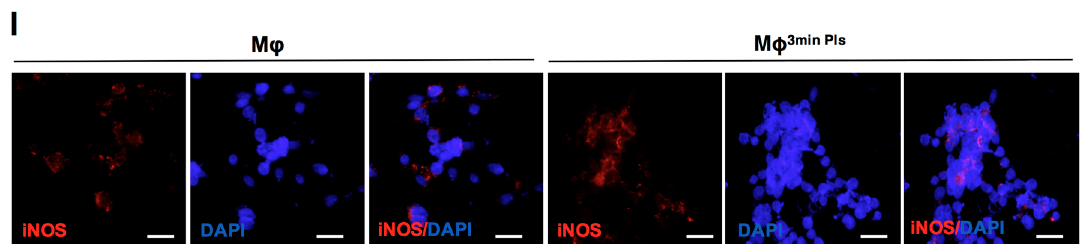
Figure 4. Expression of cold plasma-stimulated macrophage surface markers and release of cytokines by macrophages exposed to the plasma through M1 and M2 polarization. ( A ) Schematic diagram for the detection of released secretion factors during tumor-macrophage cell co-culture. To this end, plasma-stimulated THP-1 macrophages (1 × 10 5 cells/mL) were seeded in the lower chamber of the same transwell as mentioned above, while cancer cells were seeded on the top of the insert. ( B ) Microarray analysis was performed on plasma-stimulated macrophages and expression data were generated by Affymetrix Expression Console software version 1.1. To classify the co-expression gene group with a similar expression pattern, we performed hierarchical clustering using MEV (MultiExperiment Viewer) software 4.4 (www.tm4.org). More than 2-fold up genes are shown in Figure 4B ( C ) Go analysis of various signaling molecular pathways involved in altered gene expression of plasma-stimulated macrophages. ( D ) qPCR was used to validate the gene changes (related to M1 and M2 polarization) in plasma-stimulated macrophages. ( E , F ) The release of cytokines (TNF- α and IL-12) was evaluated in cell culture media after 24 h of co-culture using an ELISA assay in THP-1 treated cells as per the indicated panels. ( G ) Arginase-1 (ARG-1) was analyzed in cell culture media after 24 hrs. of co-culture using an ELISA assay in THP-1 treated cells as per the indicated panels. ( H ) Cellular metabolic viability was determined in U251 MG cells when co-cultured with plasma-stimulated macrophages in the presence of lenalidomide (2 µ M, LD), a TNF- α inhibitor, after 48 h. ( I ) Immunocytochemistry of control and 3-min plasma-treated macrophages for iNOS detection. Control group represents cells only treated with PMA for macrophage differentiation without plasma exposure. Scale bar = 100 µ m. Error bars represent the mean ± S.D. of triplicate samples. * p < 0.05 and ** p <